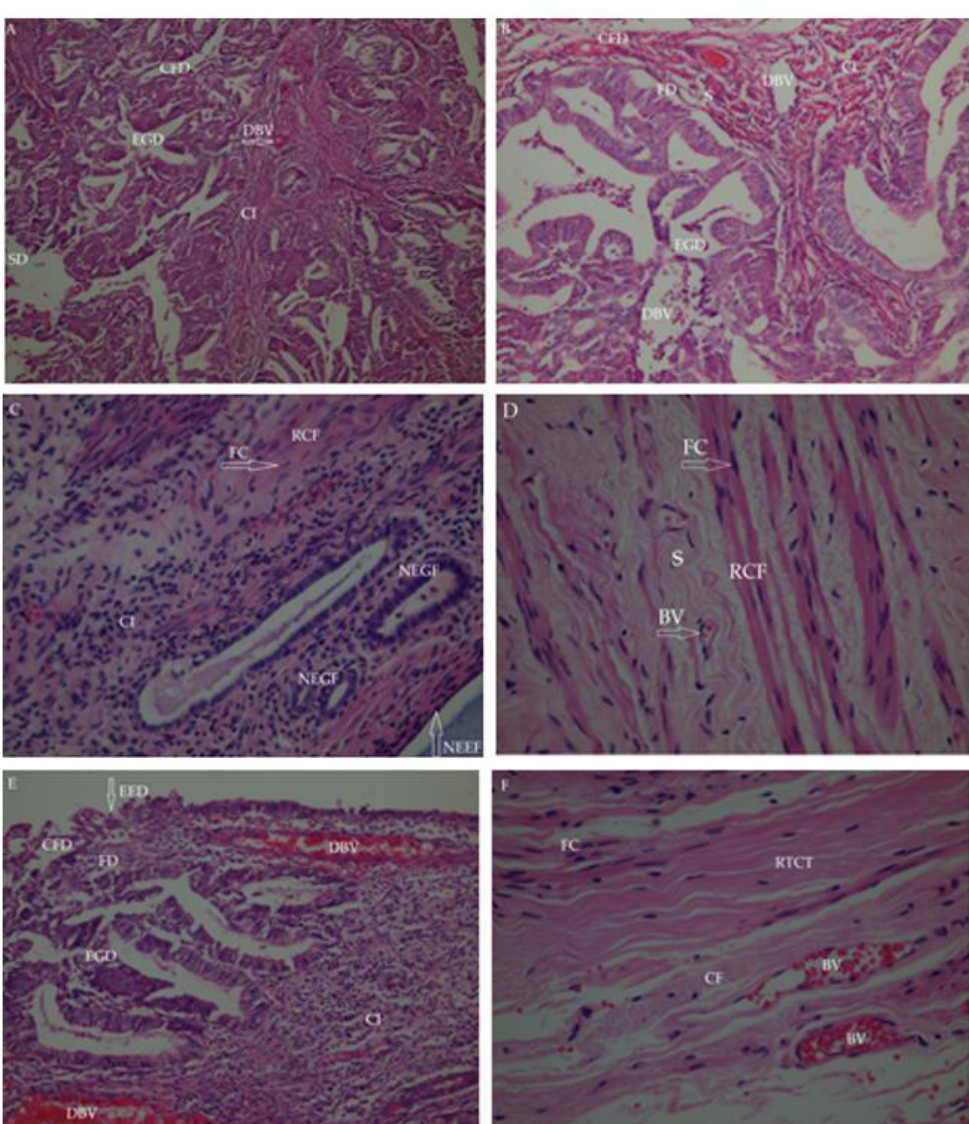
Figure 5. Histopathological findings of endometrial tissues with the treatment of test groups. ( A ) Control group; ( B ) The n -Hexane extract group; ( C ) Ethyl acetate extract group; ( D ) Methanol extract group; ( E ) Aqueous extract group; ( F ) Reference (Buserelin acetate) group. BV: Blood vessel; CFD: Collagen fiber degeneration; CI: Cell infiltration (inflammatory cells); DBV: Dilated blood vessel; EED: Endometrial epithelium destruction; EG: Endometrial gland destruction; FC: Fibroblast cell; FD: Fibroblast degenerative; NEEF: New endometrial epithelium formation; NEGF: New endometrial gland formation; RCF: Regular collagen fibers; RTCT: Regular tight connective tissue; S: Stroma; SD: Stromal destruction (connective tissue degeneration).